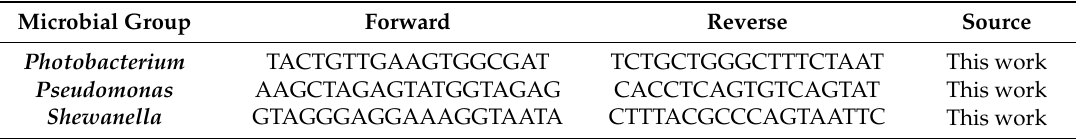
Table 3. Primers used for amplification of the di ff erent microbial groups investigated. Microbial